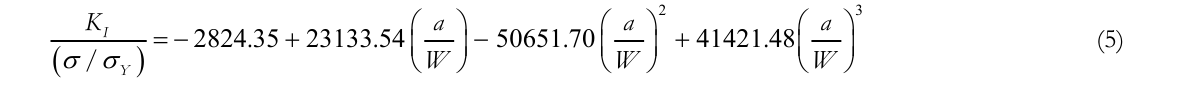
Figure 8: Variation of K present 3D FEA and Kwon and Sun [5]